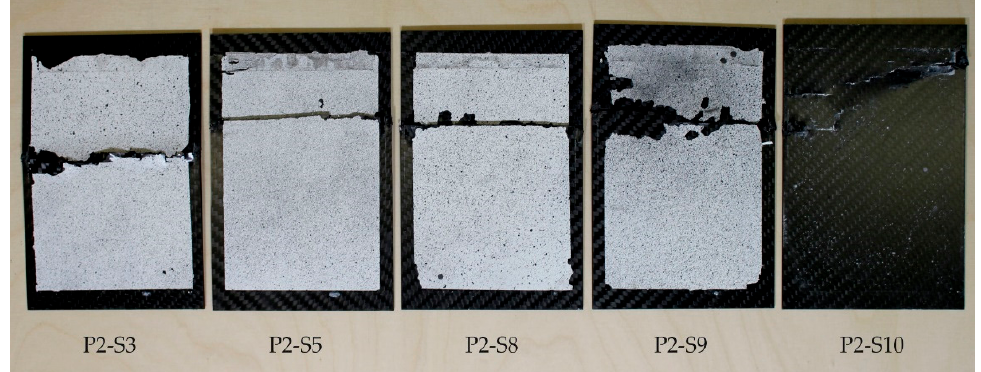
Figure A1. Front side of tested specimens P1-S1, P1-S4, P1-S5, P1-S6 and P1-S7 using CAI-standard device.